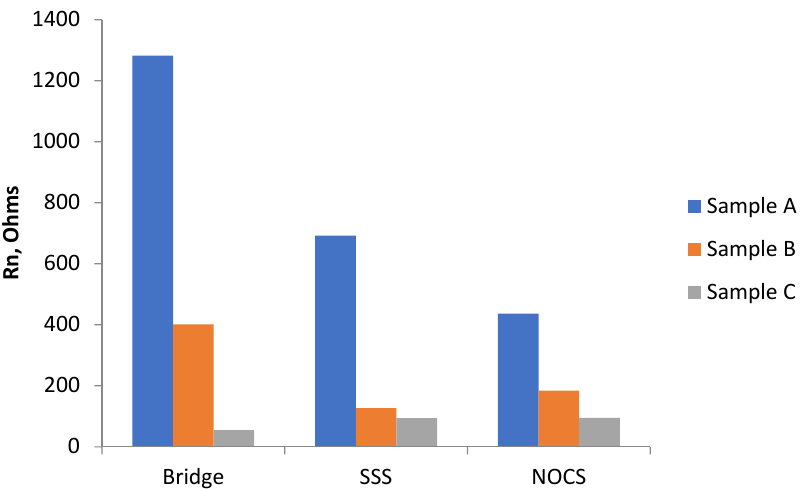
Figure 15. Comparison of R n results obtained with the three ENM arrangements over the test period from 42 days to 90 days.